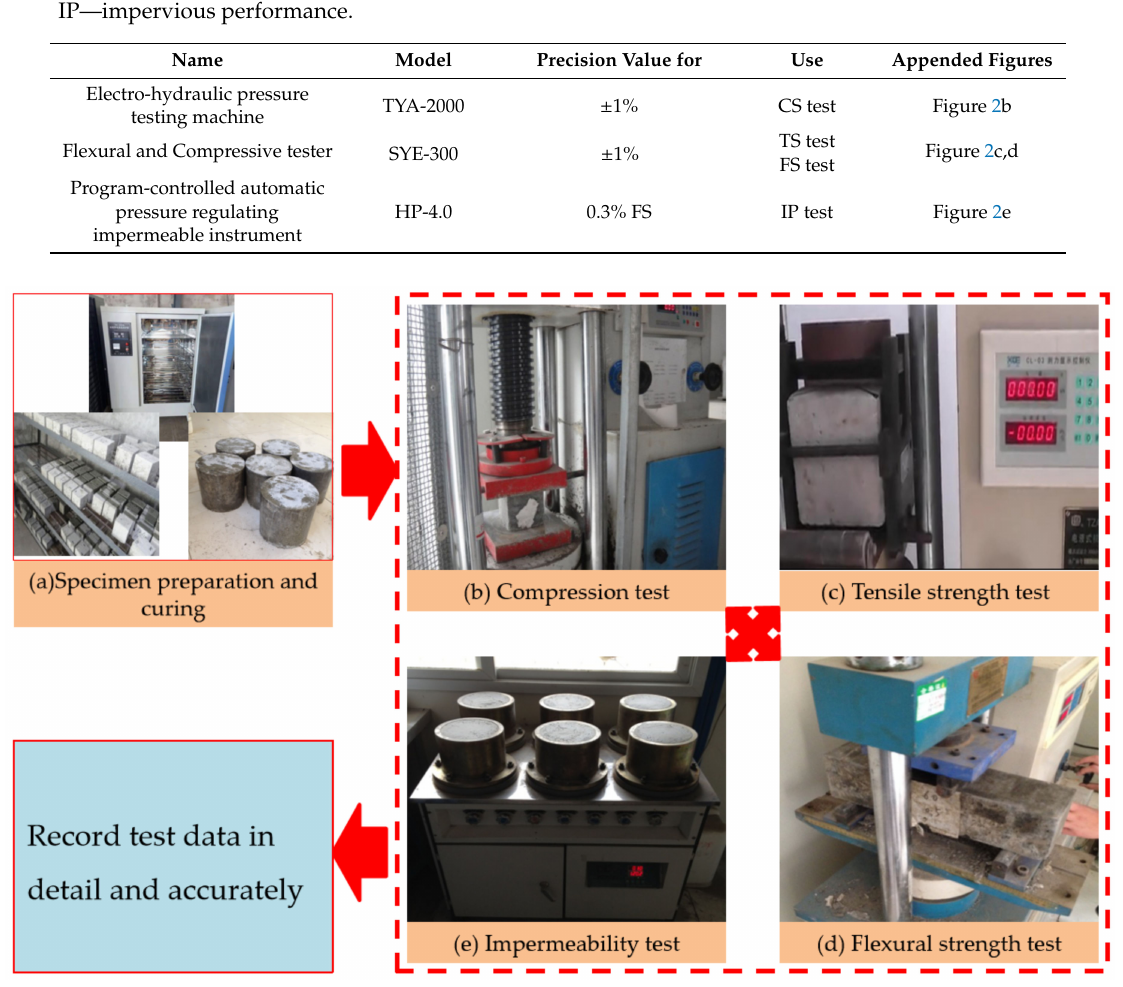
Table 2. Main test equipment. CS—compression strength; TS—tensile strength; FS—flexural strength; IP—impervious performance.